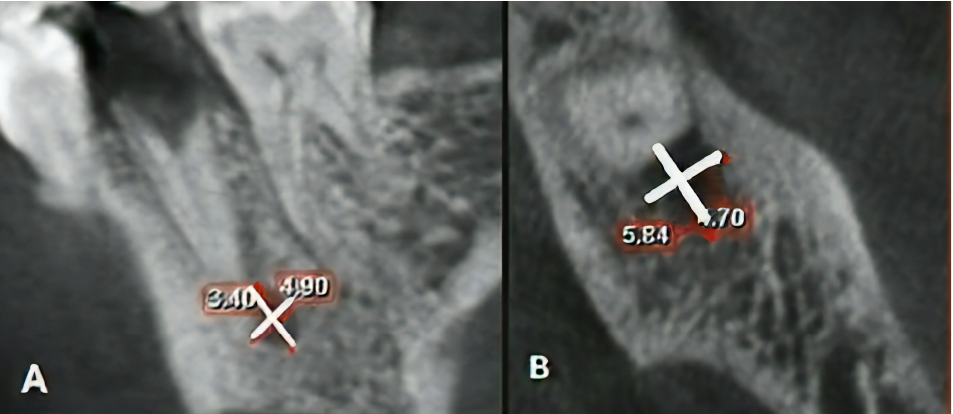
Figure 1. Measuring the dimensions of an endodontic lesion: ( A ) measuring the largest dimension of lesion in occluso-apical and mesio-distal dimensions on the sagittal view; ( B ) axial view. To determine the location of lesions, the tooth root was measured from the cementoenamel junction to the apex and hypothetically divided into three equal parts, cervical, middle, and apical. Apical lesions were considered as those in the apical third, lateral lesions were those in the middle third, latero-apical lesions were those located in the middle third to apical third, furcal lesions were those located in the furcation area, and furcal-apical lesions were those located between the furcation area and apical lesion.